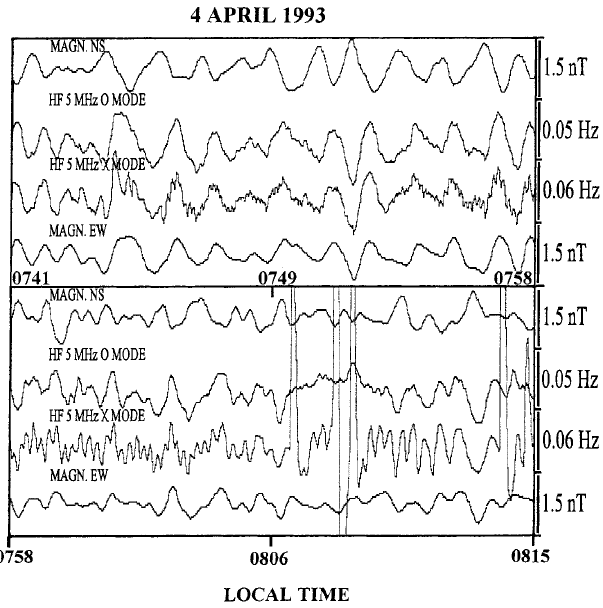
Fig. 9. Typical Pc 3-4 events recorded in both magnetoionic modes, 0741–0758 LT ( top panel ) and 0758–0815 LT ( bottom panel ), 4 April 1993. Traces in each panel are, from top to bottom : NS magnetometer component; 5.00 MHz O-mode and X-mode Doppler shifts; EW